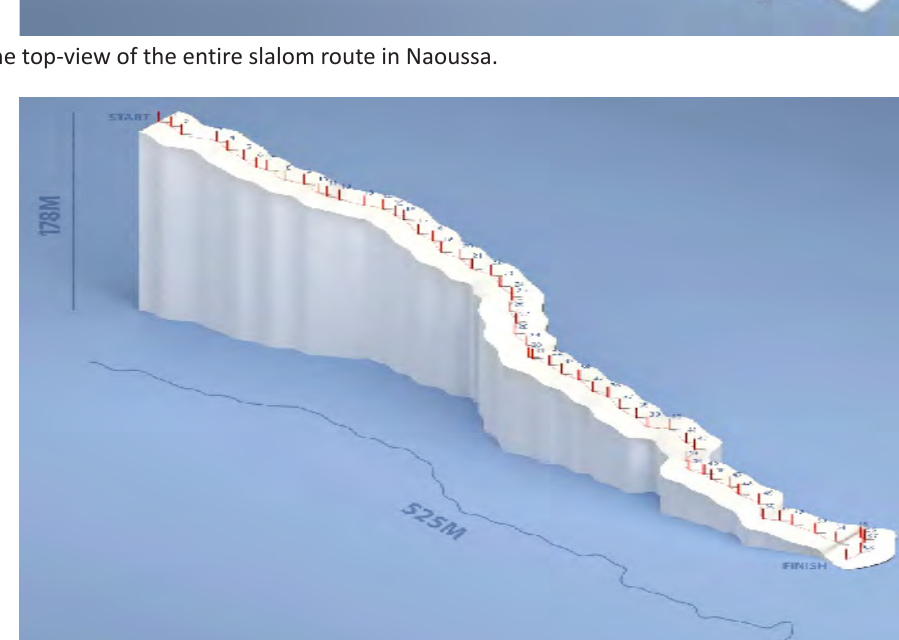
Figure 4 . The three-dimensional form of the route with 58 slalom gates in Naoussa.